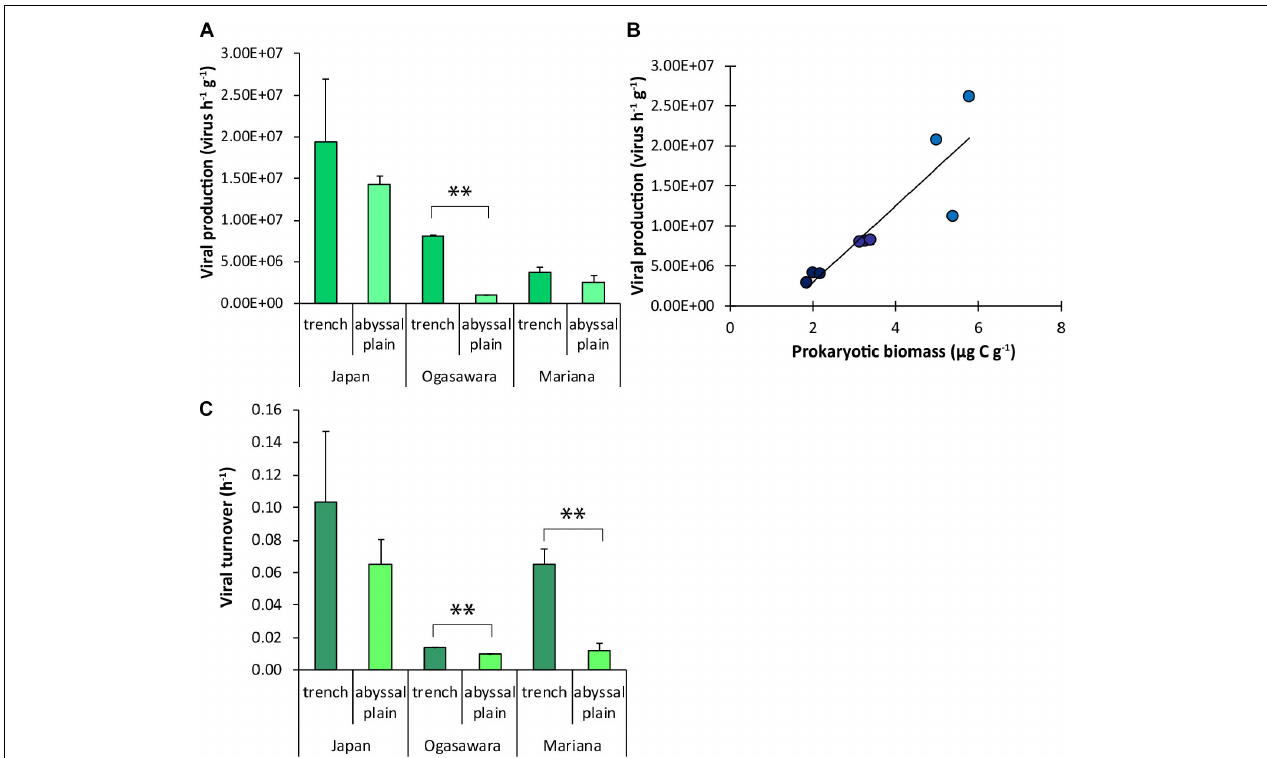
FIGURE 5 | (A) Viral production. (B) Relationship between prokaryotic biomass and viral production values in each hadal trench. The equation of the fitting line is: Y = 5 × 10 6 X – 6 × 10 6 ; R = 0.89; n = 9; p < 0.01. Dark blue dots: Mariana Trench; blue dots: Izu-Ogasawara Trench; light blue dots: Japan Trench. (C) Viral turnover rate. In (A,C) , reported are the mean values and related SDs for each hadal trench site and related abyssal site. Statistical significance is tested between hadal trench sediments and abyssal sites. ∗∗ p < 0.01.